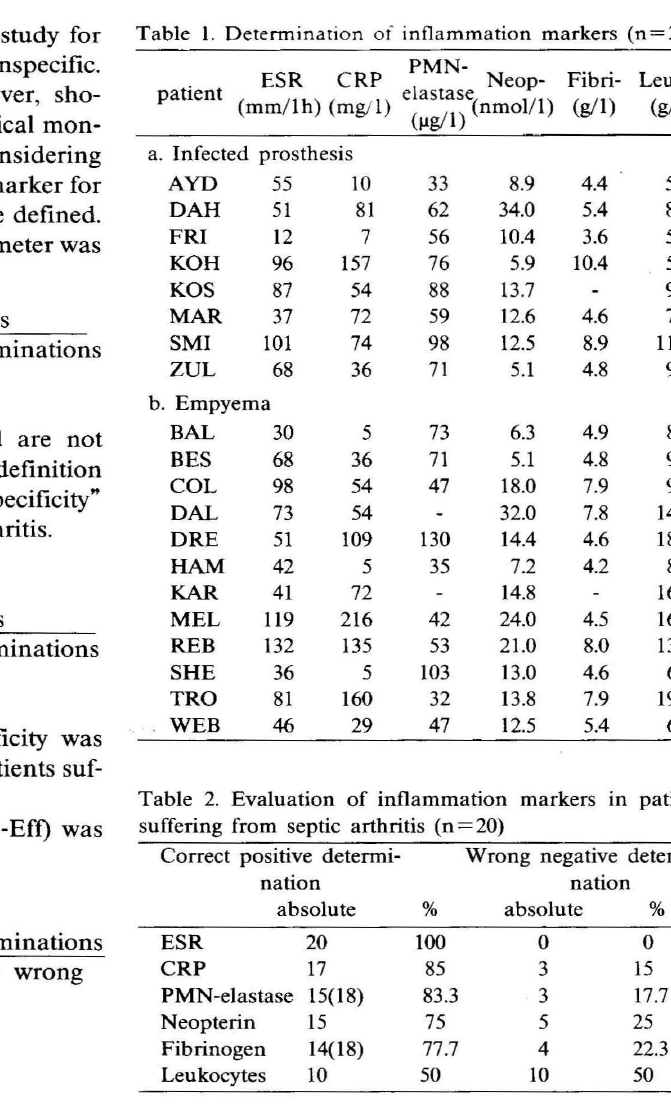
Table 2. Evaluation of inflammation markers in